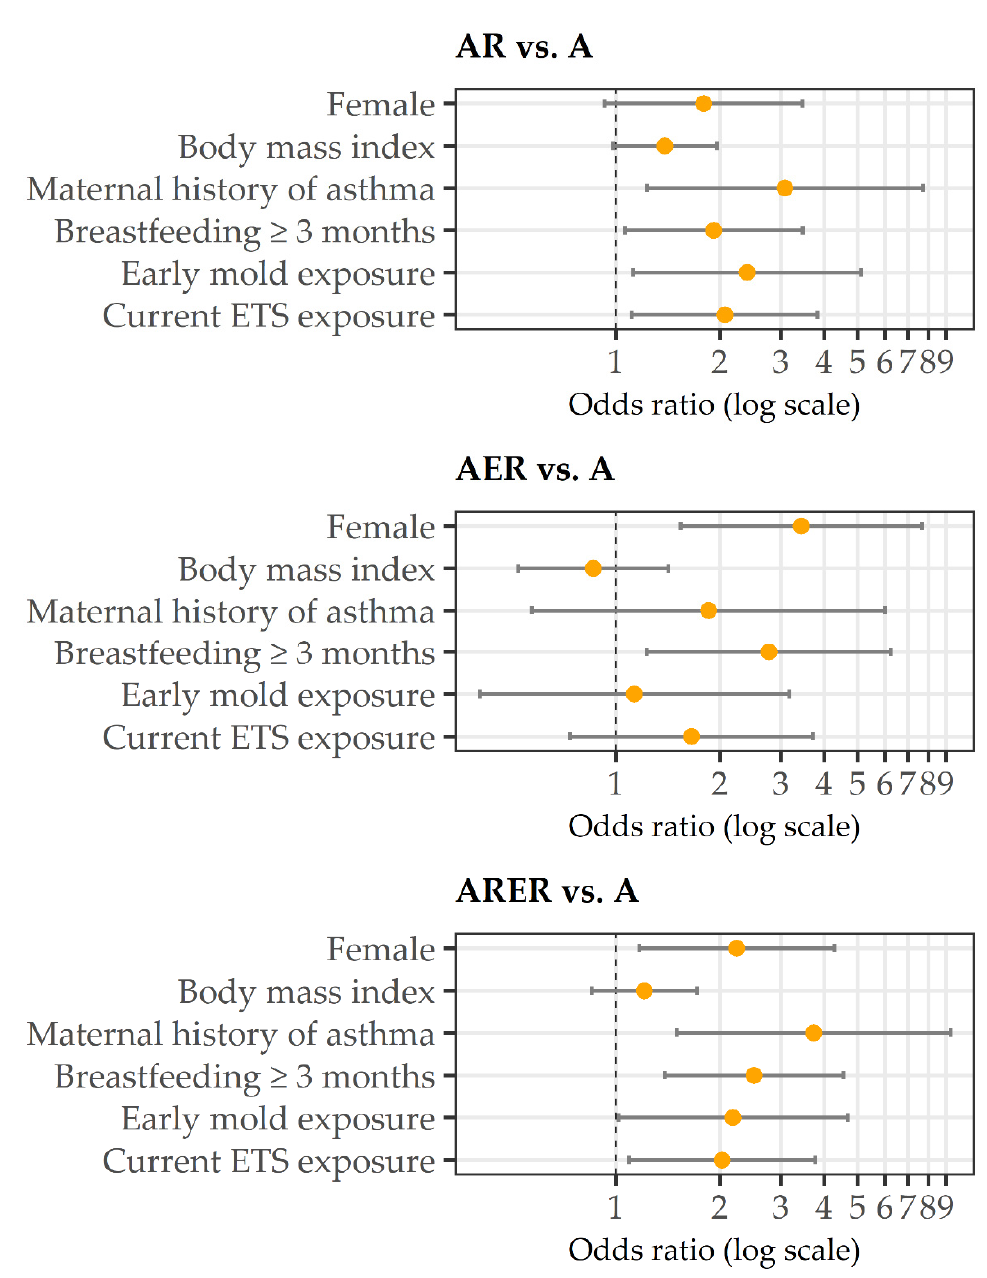
Figure 2. Estimated odds ratios (orange points) and 95% confidence intervals (bars) from the multi- nomial logistic regression model. A: asthma only. AR: asthma with respiratory comorbidities. AER: asthma with extra-respiratory comorbidities. ARER: asthma with both respiratory and extra-respiratory comorbidities. ETS: Environmental Tobacco Exposure.